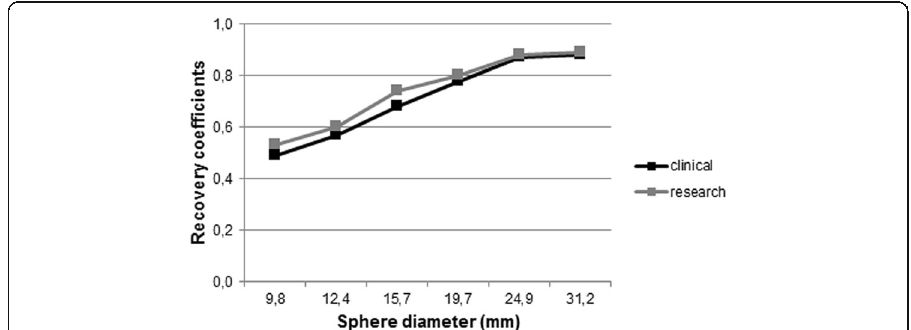
Fig. 4 Recovery coefficients for the six spheres in the small Jaszczak phantom with a sphere-to-background ratio of